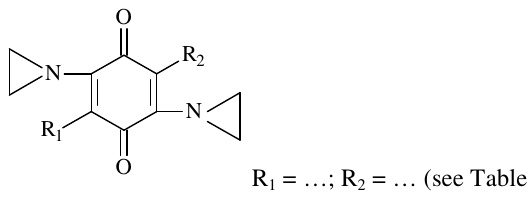
FIGURE 1 . Generic structure of carboquinone